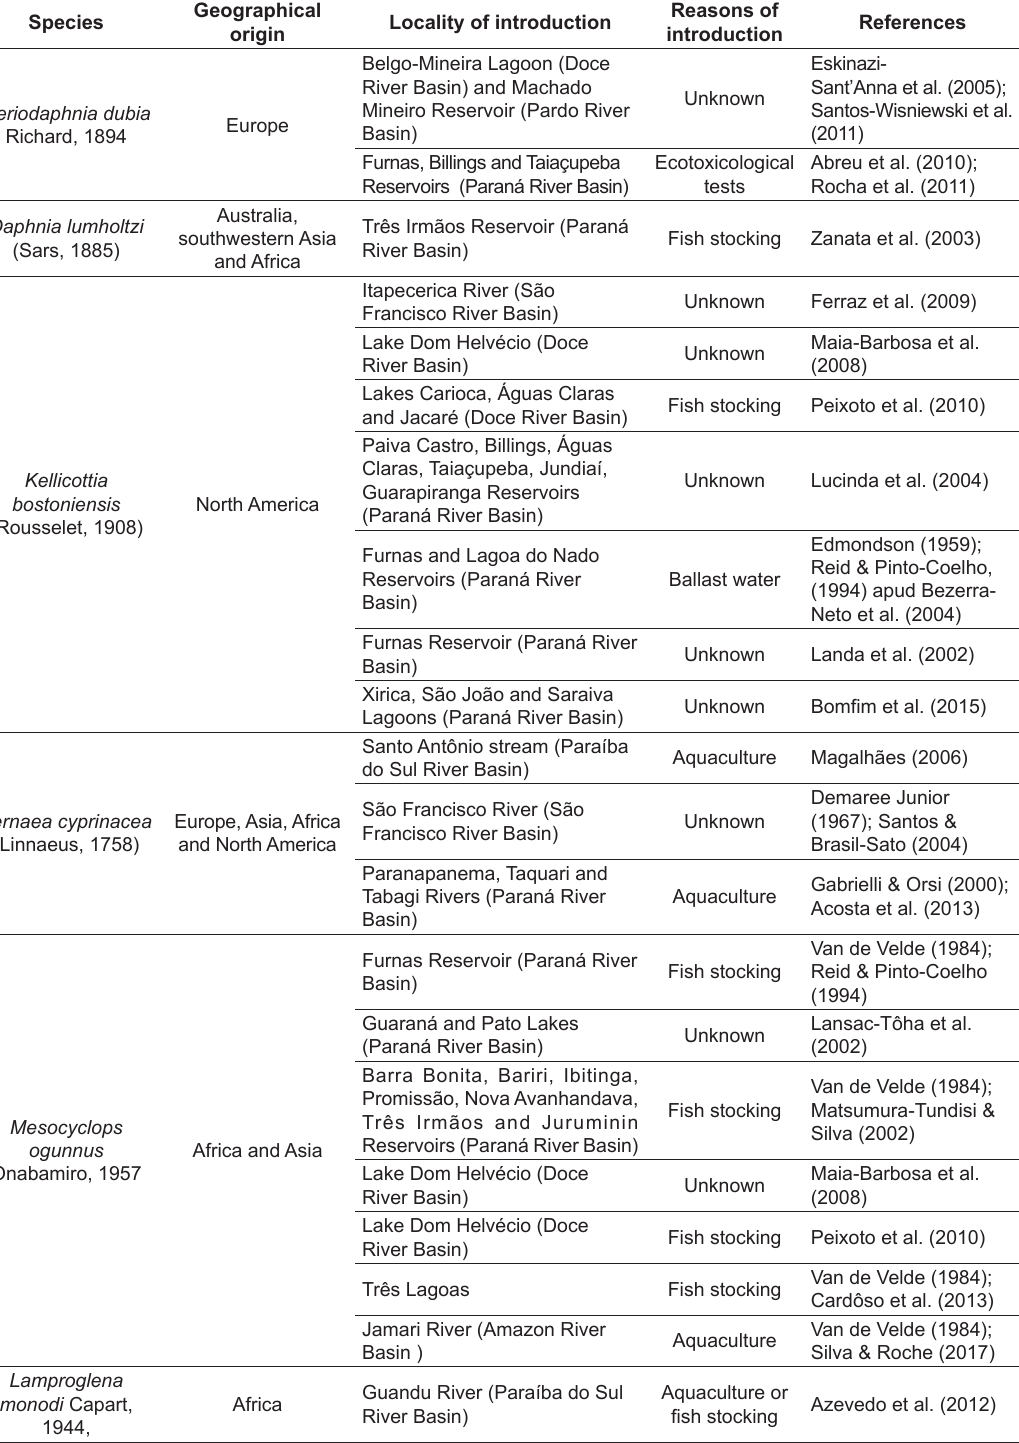
Table 1. Examples of non-native zooplankton species introduced into Brazilian freshwater environments and their possible